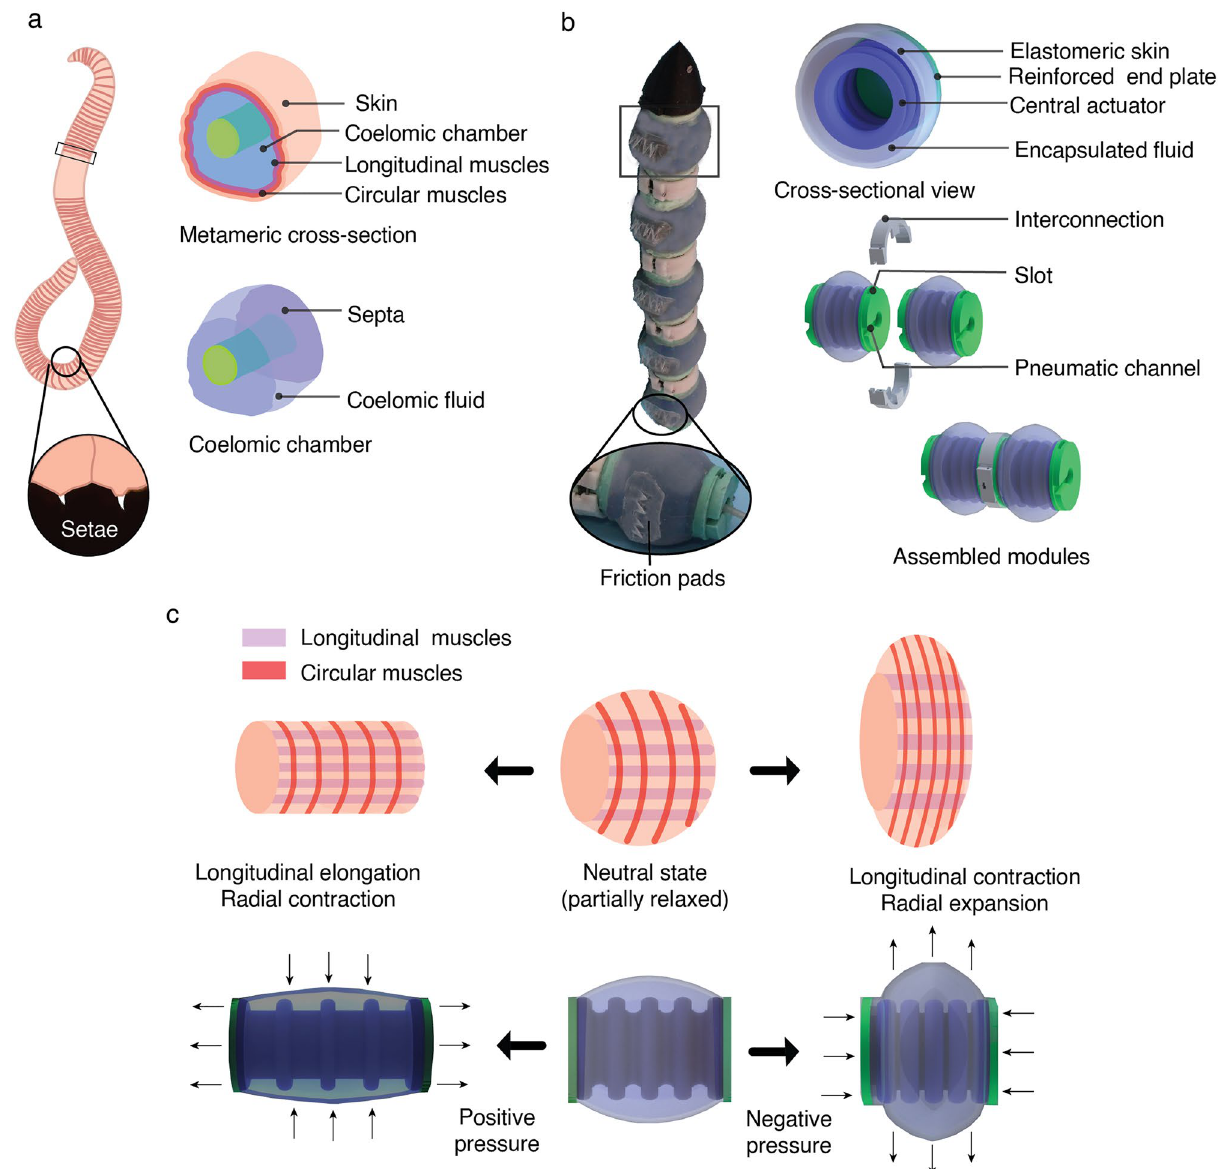
Figure 1. Design translation of bioinspired principles to a soft actuator module and a crawling soft robot. ( a) Anatomy of earthworm segment cross-section showing constant volume coelomic chambers and setae. ( b) Bioinspired PSA modules assembled in series using interconnections to form a soft robot with passive setae- like friction pads on its ventral side. (c) Working principle of the actuator with positive and negative pressure compared to the muscular motion observed in earthworm